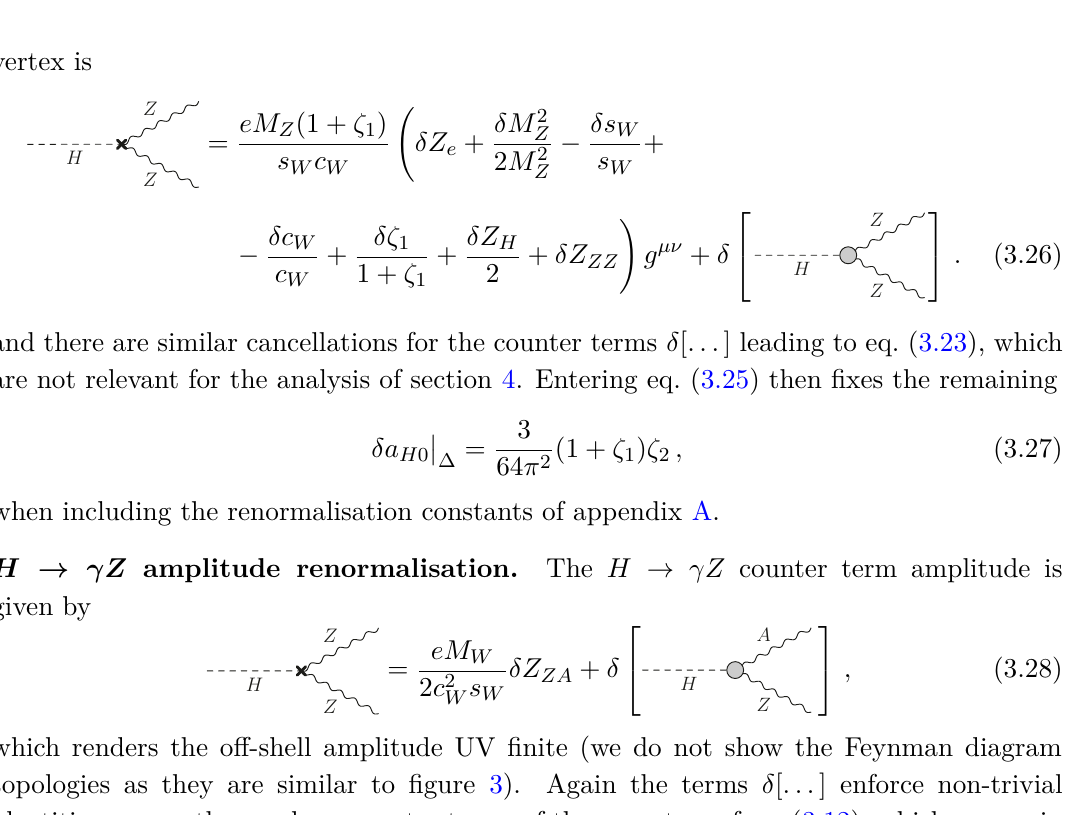
Figure 3 . Representative Feynman diagram topologies contributing to H → ZZ , similar to figure 2. Note that due to the structure of the HEFT Lagrangian, we obtain 5-point interactions in the H → ZZ channel